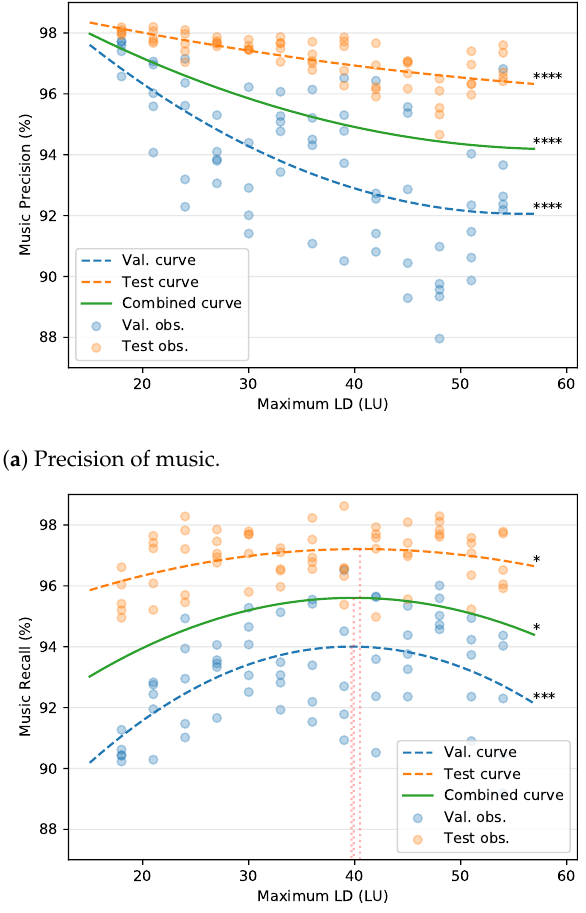
Figure 7. Evaluation of different values for maximum LD. The minimum LD was fixed at 7 LU. Validation observations (Val. obs.) and test obs. are the actual values obtained in experiments. The val. and test curves were generated through quadratic curve fitting. The combined curve aggregates the observations on val. and test set for quadratic curve fitting. ANOVA was performed on the observations and the asterisks indicate the level of significance (*: p < 0.05, **: p < 0.01, ***: p < 0.001, ****: p <